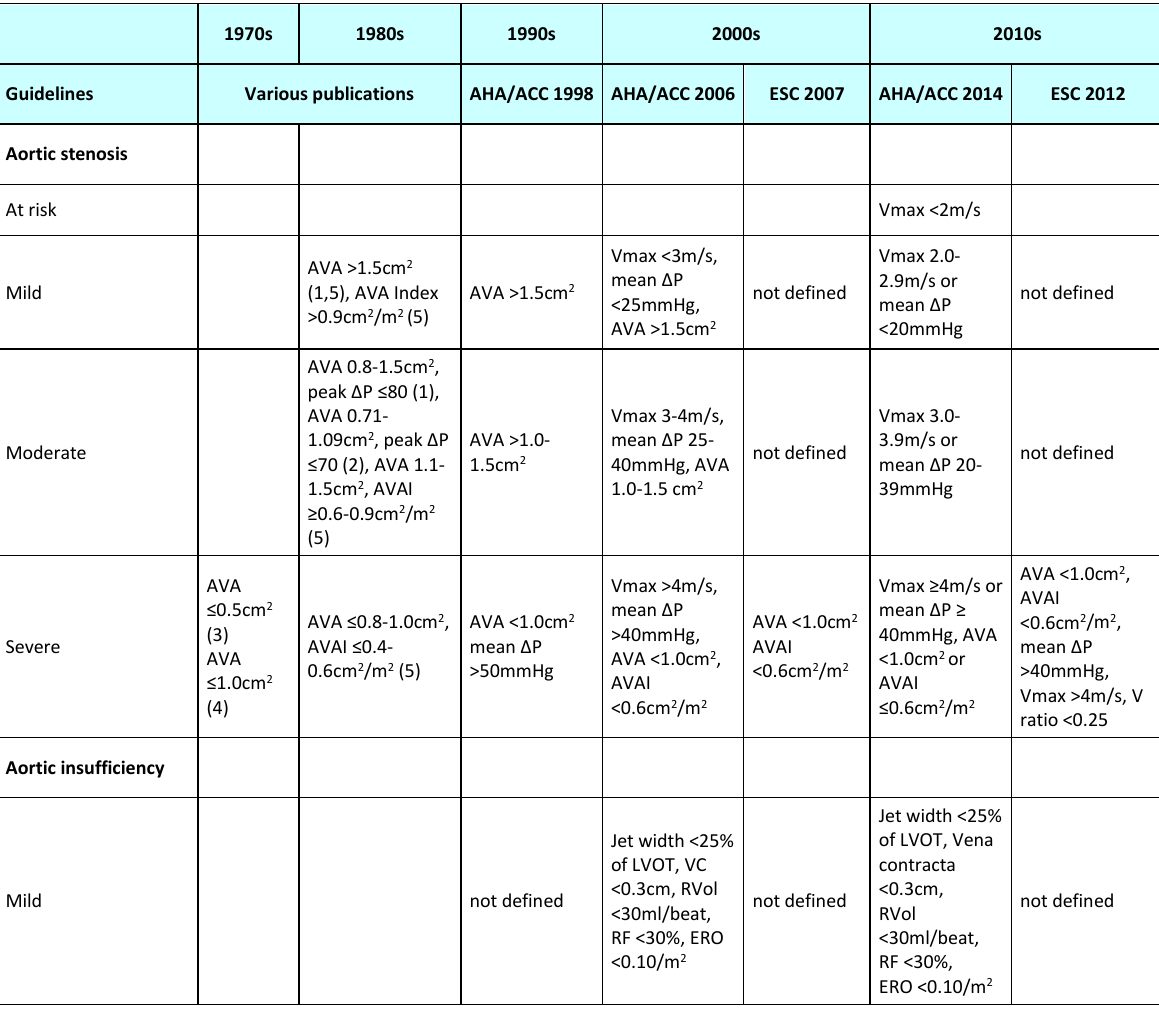
Table S1: Definitions of valve lesions according to guidelines and proposals